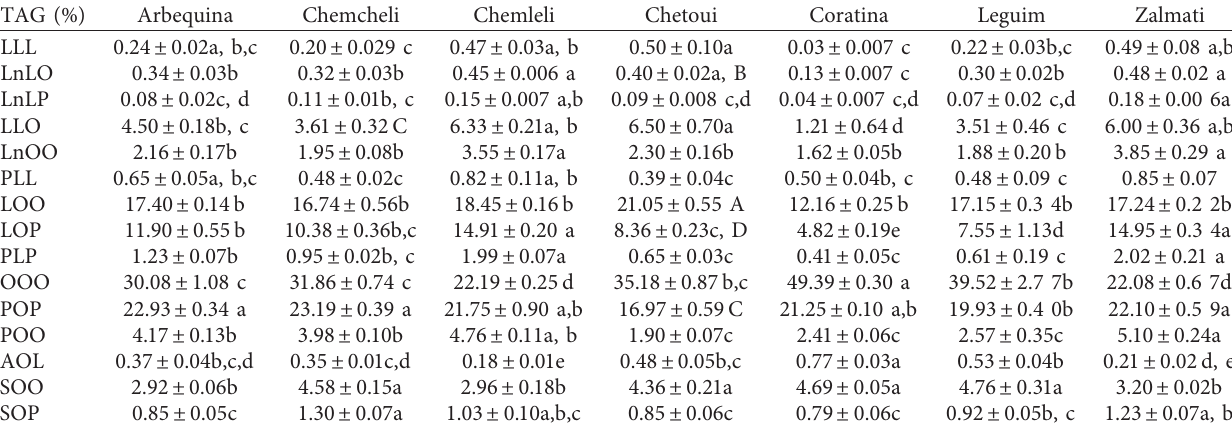
Mean values in the same row with the same letter are not significantly different between